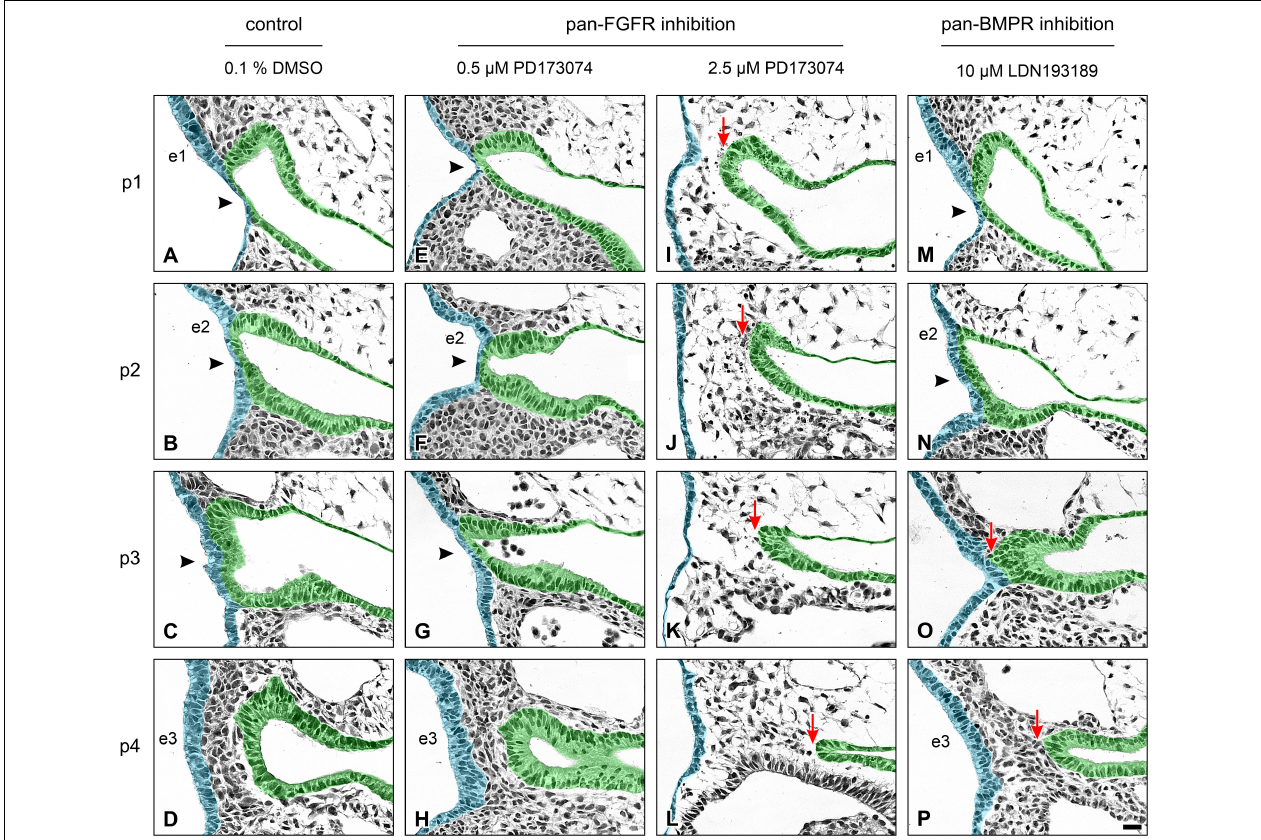
FIGURE 2 | Impact of FGFR or BMPR inhibition on the development of pharyngeal pouches (p1–p4) in 9–14 somite mouse embryos, cultured for 24 h. Hematoxylin stained sections show the pharyngeal pouches (green), the overlying ectoderm (blue), the three epibranchial placodes (e1–e3), and the branchial membranes 1–3 (black arrowheads). (A–D) Control embryos: Age-appropriate lateral outgrowth of the pharyngeal pouches 1–4, whereby the latter physiologically does not fuse with the overlying ectoderm to form a “branchial membrane 4”. (E–H) Embryos incubated with 0.5 µ M of the pan-FGFR inhibitor PD173074 develop largely normal pharyngeal pouches. (I–L) Treatment with 2.5 µ M PD173074 prevents proper outgrowth of all pharyngeal pouches (red arrows). Neither branchial membranes nor epibranchial placodes are discernible. (M–P) Following application of the pan-BMPR inhibitor LDN193189, pharyngeal pouches 1 and 2 develop normally, whereas lateral outgrowth of the pharyngeal pouches 3 and 4 is impaired (red arrows) with pharyngeal pouch 3 contacting the ectoderm in one single histological serial section, if at all. Scale bar: 20 µ